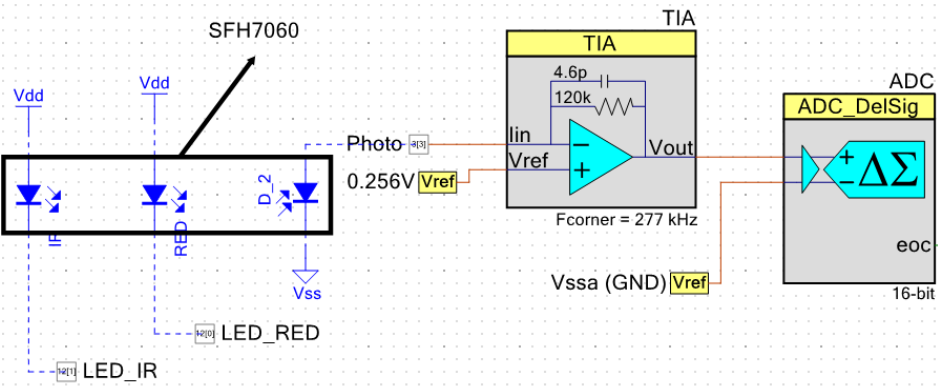
Figure 3. Schematic of the PPG subsystem. TIA = Trans-Impedance